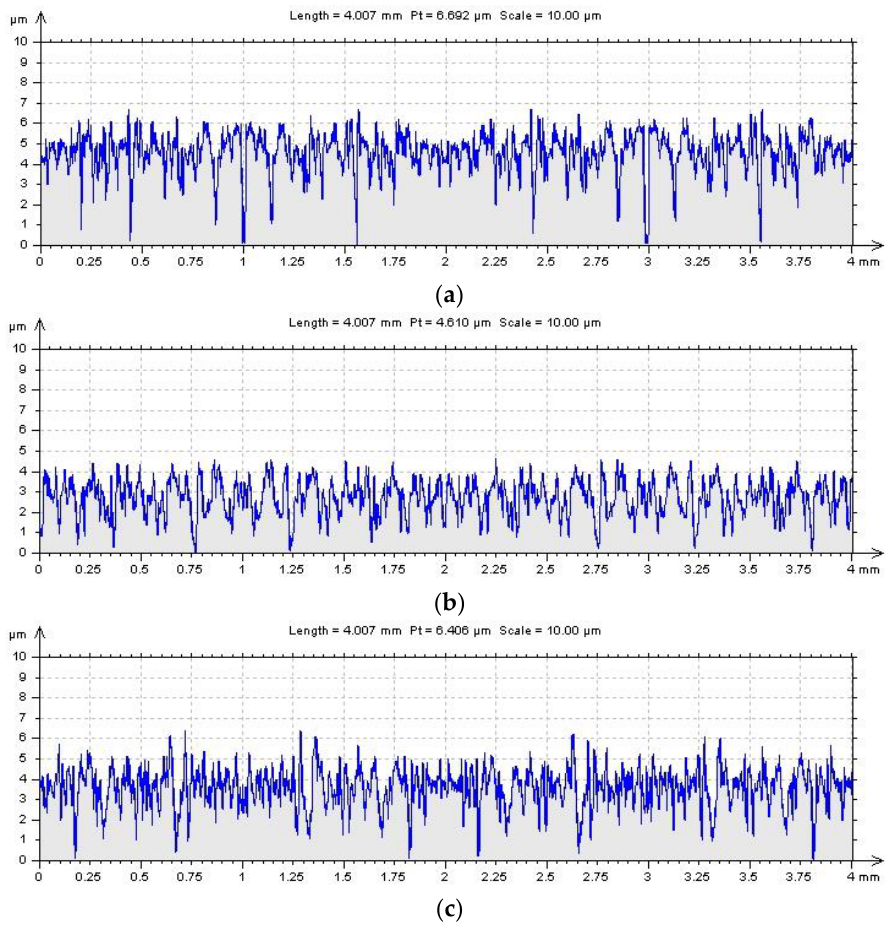
Figure 6. Surface roughness profiles: ( a ) ground surface; ( b ) surface after plasma nitriding; ( c ) surface after gas nitriding.